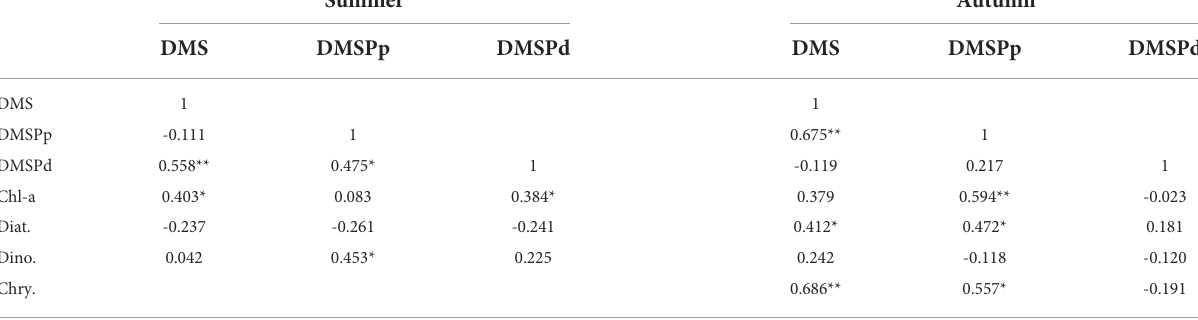
TABLE 3 Correlation between the concentration of DMS and DMSP and the biological factors in the surface waters of BS and NYS in summer and autumn.